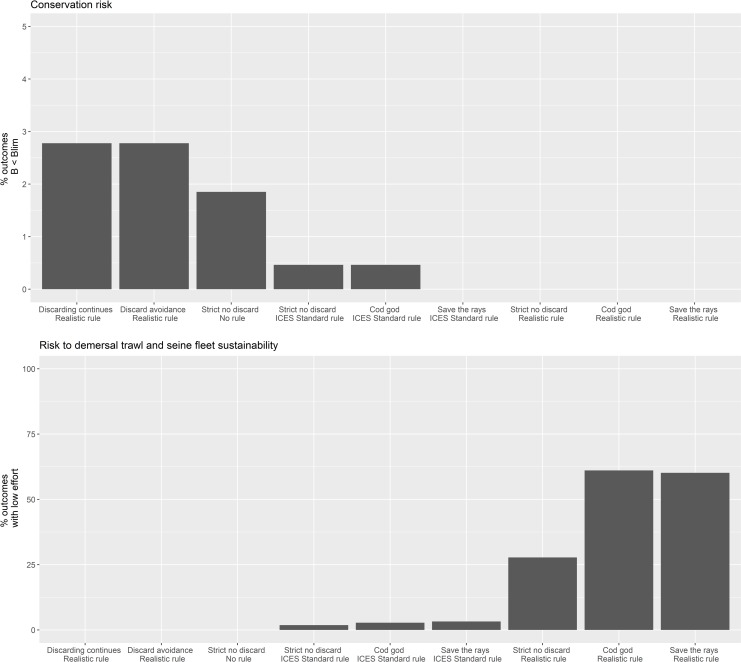
Contrast in risk to conservation species biomass (top) and sustainability of the principal fishery (bottom).Conservation species—common skate and cuckoo ray). Principal fishery—demersal trawl and seine fleet. Low effort is defined as ≤ 10% of fishing effort in 1990) between 9 strategies each fishing at Fmsy by 2020. The contrast between bars 1, 2 and 7 shows the change in risk due to change in discard regulation options only as each is safeguarded by HCR Type 4. Bars 3 and 4 contrast the change in risk when the safeguard as applied in column 7, is either removed or altered to HCR Type 1 (See Fig 4). Bars 5 and 8 demonstrate the effect of a management strategy focused on reducing risk to the depletion of cod (‘Cod god’ strategy, see text, using HCR Type 1 and 4 respectively). Bars 6 and 8 demonstrate the effect of a management strategy focused on reducing risk to the depletion of skates and rays (‘Save the rays’ scenarios, see text, using HCR Type 1 and 4 respectively).